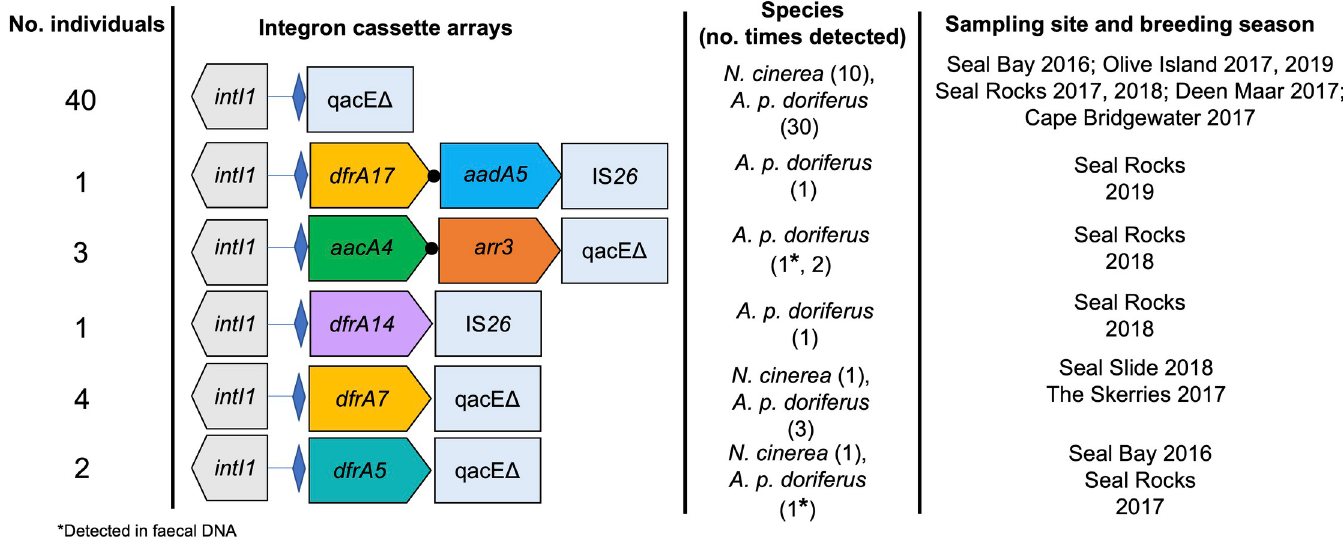
Fig 3. Schematic map of class 1 integron gene cassette arrays identified in N . cinerea and A . p . doriferus across all sampling sites and breeding seasons. Number of individuals with each array are listed on the left-hand side. Gene cassettes are represented as broad arrows. Blue diamonds represent the primary integron recombination site, attI1 , where gene cassettes are inserted following acquisition; black circles represent gene cassette recombination site, attC . Gene symbols are as follows: dfrA genes encode dihydrofolate reductases that confer resistance to trimethoprim; aacA genes encode aminoglycoside (6’) acetyltransferases ( aacA ) that confer resistance to aminoglycoside antibiotics; aadA genes encode aminoglycoside (3”) adenylyltransferases that confer resistance to streptomycin and spectinomycin; arr3 genes encode ADP-ribosyl transferases that confer resistance to rifampin; qac genes encode efflux pumps that confer resistance to quaternary ammonium compounds; qacE Δ and IS 26 represent the 3’ terminus of some the gene cassette arrays depicted.